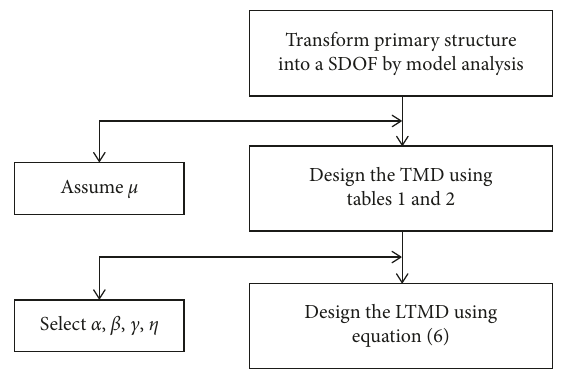
Figure 3: Flowchart for designing the